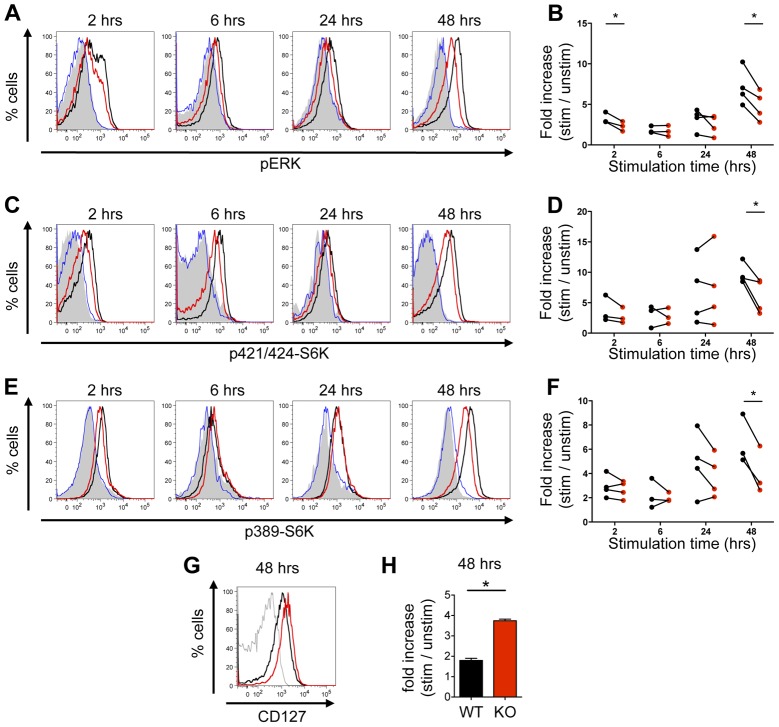
mTOR activity is decreased in KSR1-deficient T cells.Splenocytes from WT or KSR1-/- mice were cultured with or without anti-CD3 + anti-CD28 (5 µg/mL each) stimulation for 2 to 48 hrs. Phosphorylation of ERK (A, B), T421/S424-S6K (C, D) and T389-S6K (E, F), and expression of CD127 (G,H) in CD8+ T cells was measured by flow cytometry. A, C, E: Representative histograms of unstimulated WT cells (filled grey histogram), unstimulated KO cells (blue line), and WT (black line) or KO (red line) cells stimulated with CD3+CD28, gated on CD8+ T cells. Graphs are representative of 3 to 4 experiments. C, D, F: Fold increase phosphorylation of ERK, T421/S424-S6K and T389-S6K in stimulated WT (black) and KO (red) CD8+ T cells compared to non-stimulated cells. Each dot represents an independent experiment. p-ERK, p-T421/S424-S6K and p-T389-S6K levels were normalized within each experiment to unstimulated control T cells. *: p<0.05, paired t-test. G-H. Representative histograms (G) and fold increase in comparison to non-stimulated control T cells (H) of CD127 expression in WT (black) and KO (red) cells stimulated with CD3+CD28, gated on CD8+ T cells. Grey line: isotype control. H. Data is presented as mean + SEM and is representative of two independent experiments. *: p<0.05, unpaired t-test.